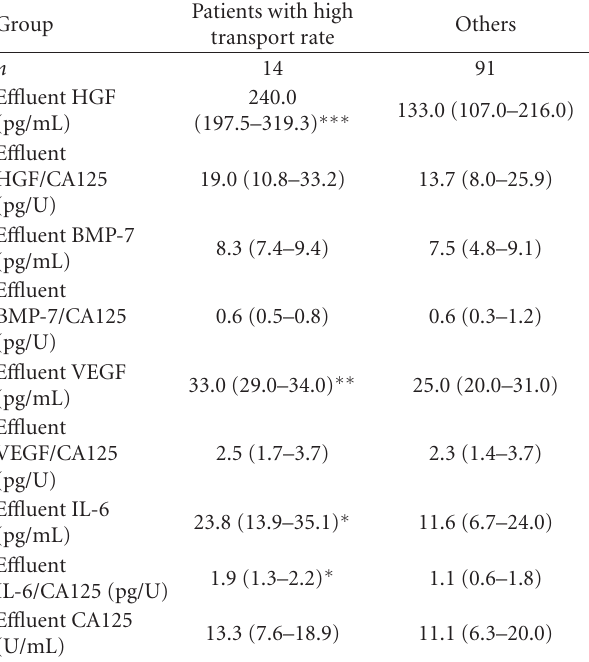
Table 2: E ffl uent markers and e ffl uent markers-to-e ffl uent cancer antigen 125 ratio in patients with high transport rate and